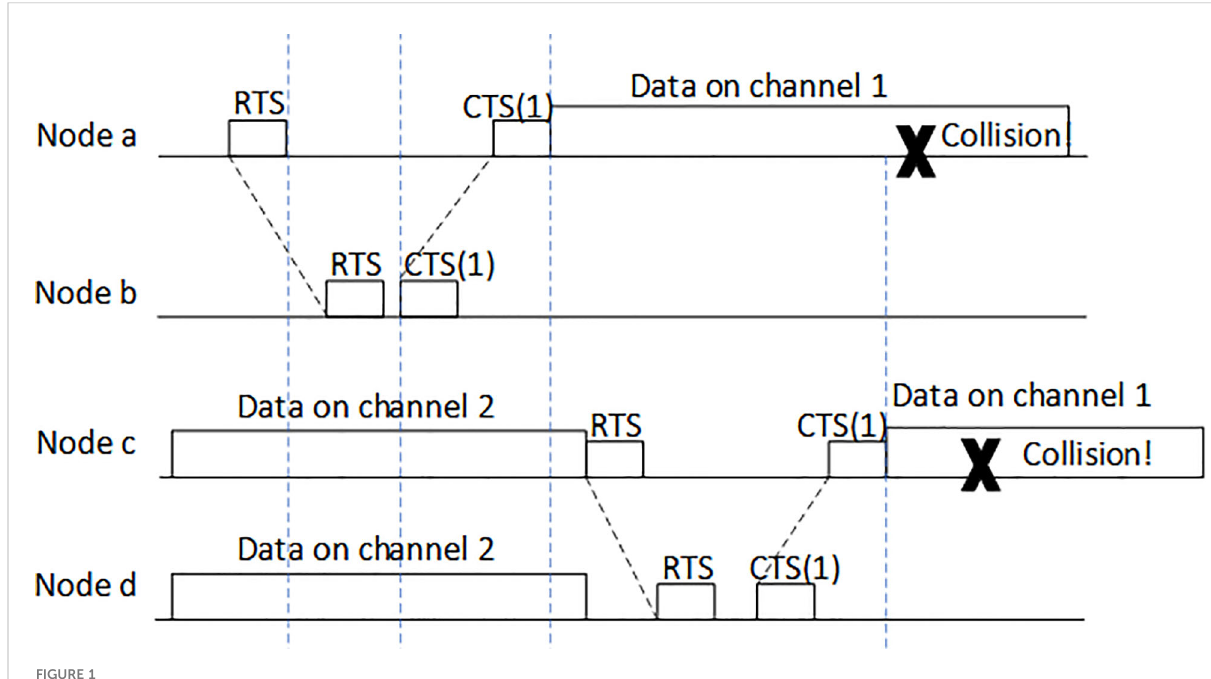
FIGURE 1 Multichannel hidden terminal